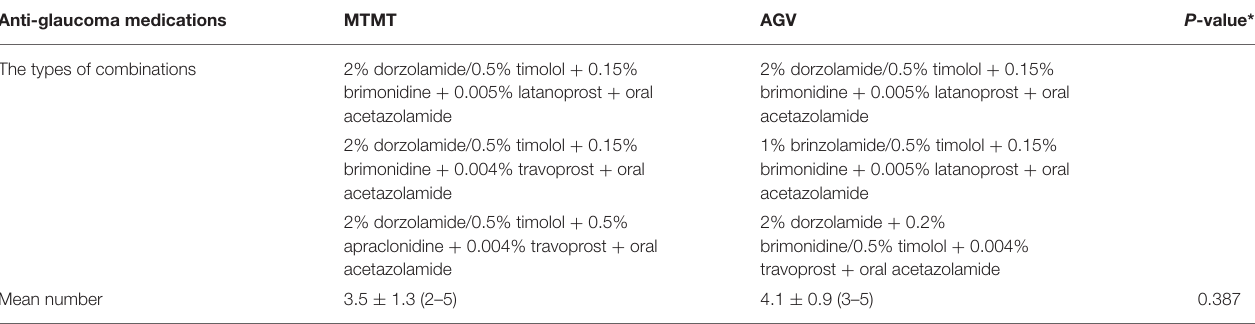
TABLE 2 | The types of combinations of anti-glaucoma medications used in the MTMT and AGV groups. Anti-glaucoma medications MTMT AGV P -value* The types of